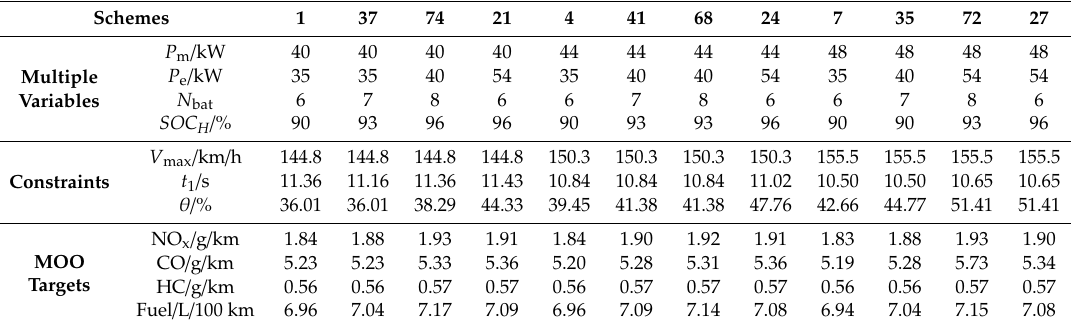
Table 4. Multiple variables, constraints and the MOO targets under NEDC conditions